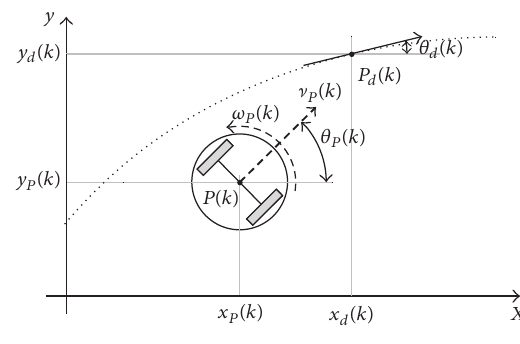
Figure 1: Mobile robot